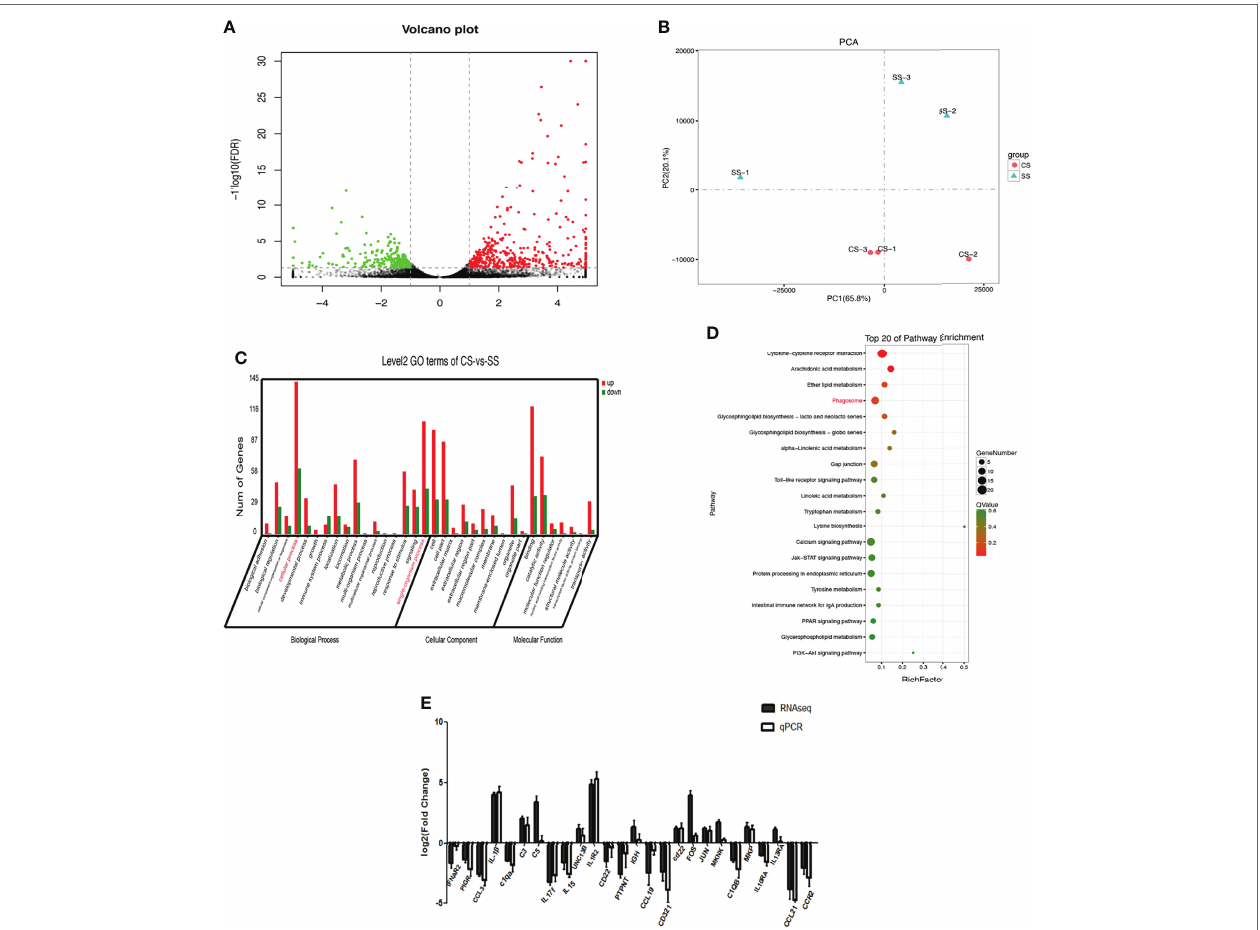
FIGURE 2 | Differential gene expression by transcriptome sequencing. (A) Volcano plot presents the DEGs between CS and SS groups. Down-regulated DEGs are marked in green, and up-regulated DEGs are marked in red. The black dots stand for those genes without significant changes. (B) PCA compared the differences in transcriptome among the CS and SS groups. (C) GO analysis of the transcriptome data. (D) KEGG analysis of the DEGs. (E) Verification of representative DEGs by qRT-PCR.